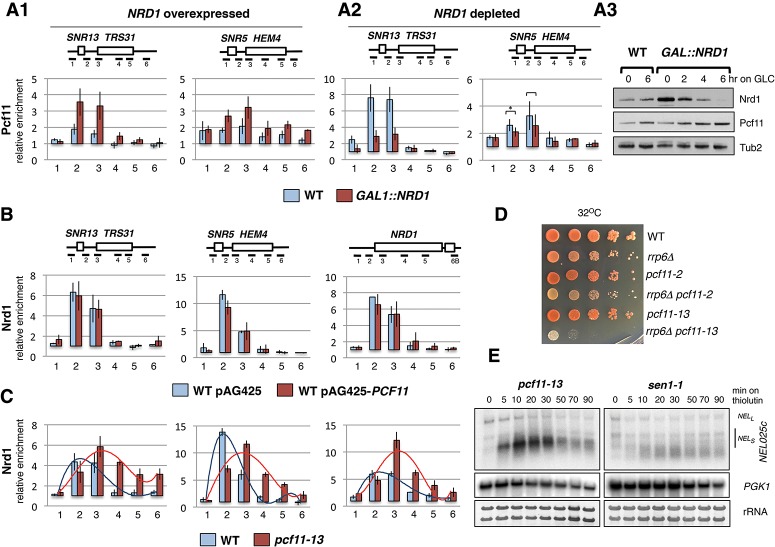
Interdependence between Nrd1 and Pcf11 recruitment over NRD-dependent genes. ChIP analysis on the indicated genes of Pcf11 recruitment in Nrd1-overexpressed (A1) and Nrd1-depleted (A2) cells. Expression of GAL1:NRD1 was shut down for 6 h at 30°C prior to analysis. (A3) Western blot showing levels of Nrd1 and Pcf11 following either NRD1 overexpression or depletion. Anti-Nrd1, anti-HA, and anti-Tub2 antibodies were used to detect Nrd1, Pcf11-HA, and Tub2, respectively. (B) ChIP analysis on the indicated genes of Nrd1-TAP recruitment in cells overexpressing Pcf11; cells transformed with the respective plasmids were grown in SD −ura at 30°C. (C) ChIP analysis on the indicated genes (as for B) of Nrd1 recruitment in pcf11-13. Trend lines emphasize Nrd1 profiles. (D) Growth tests of the rrp6Δ pcf11-13 strain at an elevated temperature. Dilutions (1:10) were grown for 4 d at 32°C on SD medium. (E) Northern blots showing transcriptional shutoff analysis of NEL025c ncRNA in pcf11-13 and sen1-1. Cells were incubated at the nonpermissive temperature for 30 min prior to thiolutin-specific transcription inhibition. NEL025c long (NELL) and short (NELS) forms are indicated. PGK1 mRNA and rRNA were used as degradation and loading controls. Diagrams above the graphs depict loci and positions of amplicons. The box at the 3′ end of NRD1 represents the TAP tag. The average of three experiments showing fold enrichment over the background control from a nontranscribed region on Chromosome V (>1) is shown. Error bars represent standard deviation of repeats.